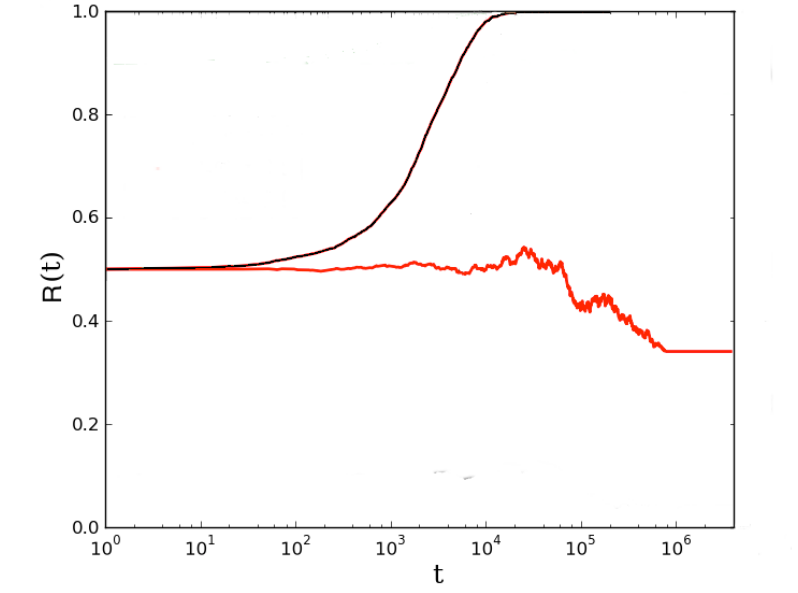
Figure 1. Mean field analysis of a population playing Poker. Amount of rational agents over time R ( t ) ( + 1 indicates rational, − 1 irrational) in the two different configurations analyzed in [9], for the case with an equal starting density of rational and irrational agents. Black line indicates the result achieved with full challenges. Red line indicates the result achieved with one-round challenges. Results have been averaged over different simulation